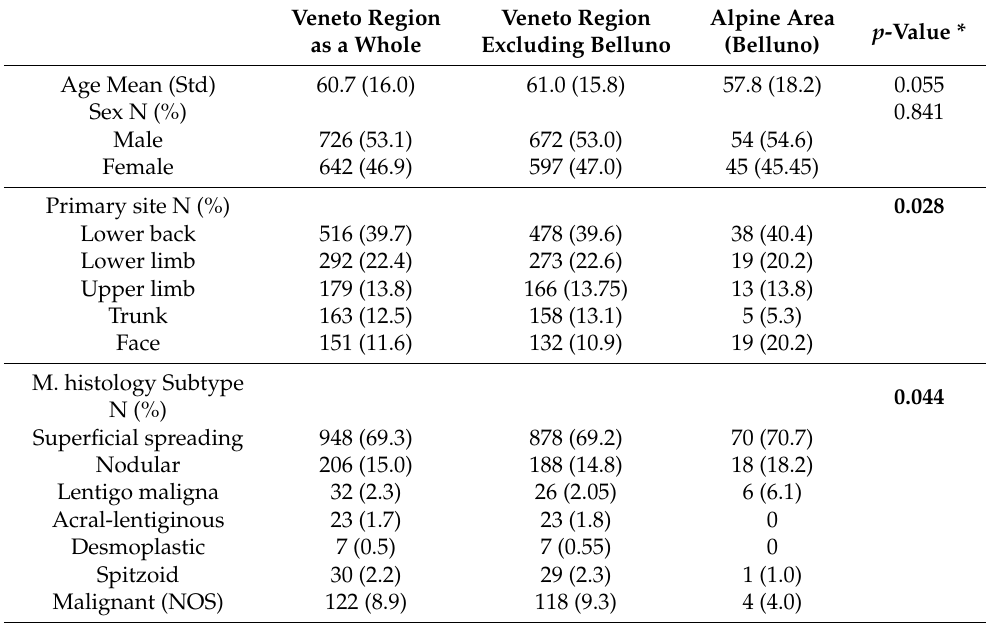
Table 2. Different CMM histological variables distribution in the regional population as a whole, in the provinces other than Belluno, and in the Alpine province of Belluno. M: melanoma; TILs: tumor-infiltrating lymphocytes (Brisk is not